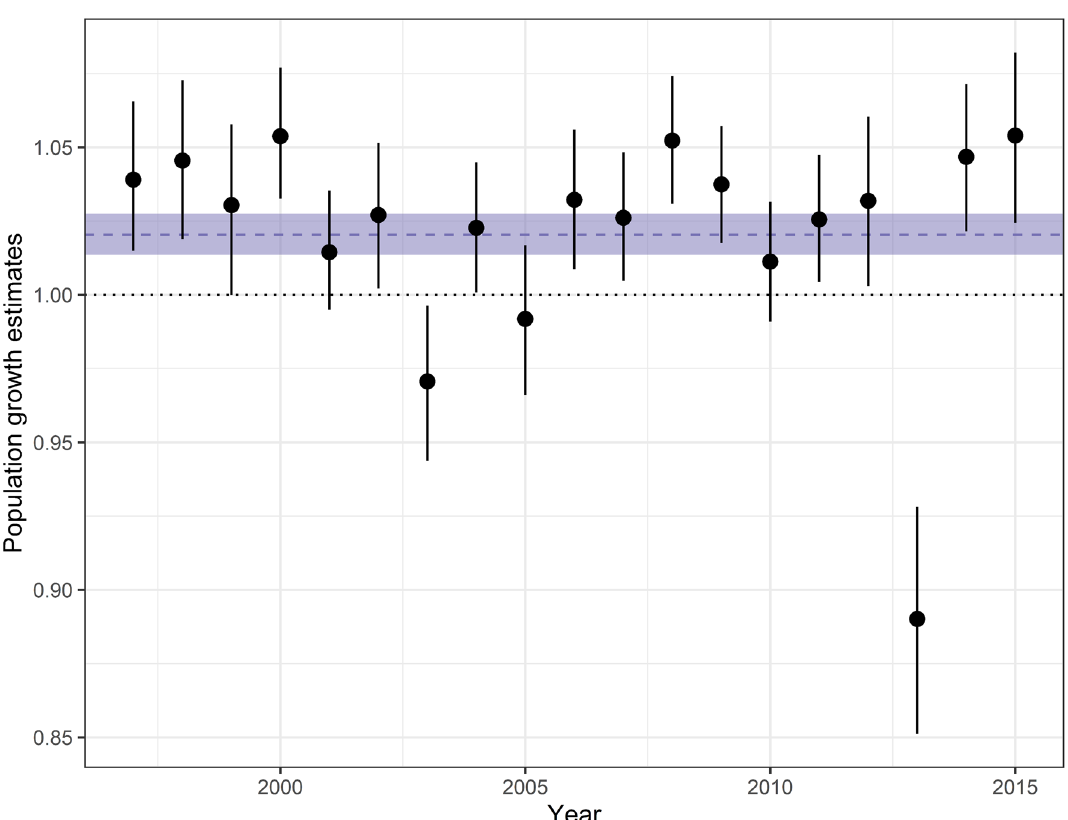
Figure 4. Population growth rate estimates (medians and 95% credible intervals) from IPM, 1997–2015. Population stability (growth rate = 1) is indicated with a dotted line. Average population growth rate (geometric mean across years) is indicated with a dashed line; ribbon indicates 95%